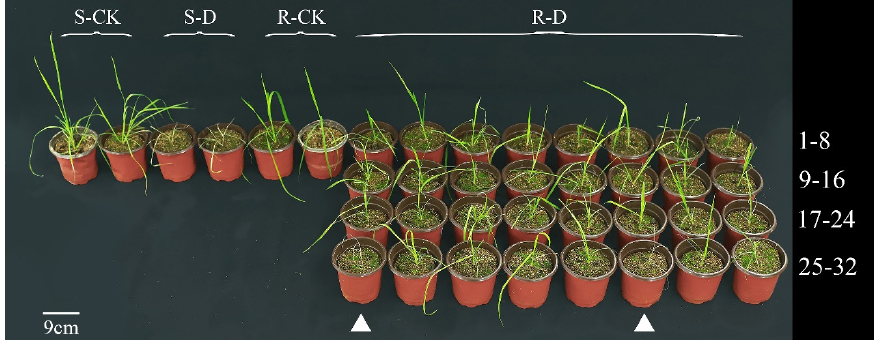
Figure 3. Growth effects of 32 R plants and 2 S plants used for dCAPS markers 21 days after quizalofop-p-ethyl application. Notes: S-CK, for S plants with treatment of water; S-D, for S plants with treatment of quizalofop-p-ethyl; R-CK, for R plants with treatment of water; R-D, for R plants with treatment of quizalofop-p-ethyl; 1–32, numbering of R plants. Two dead plants are marked with white triangles in the R population.